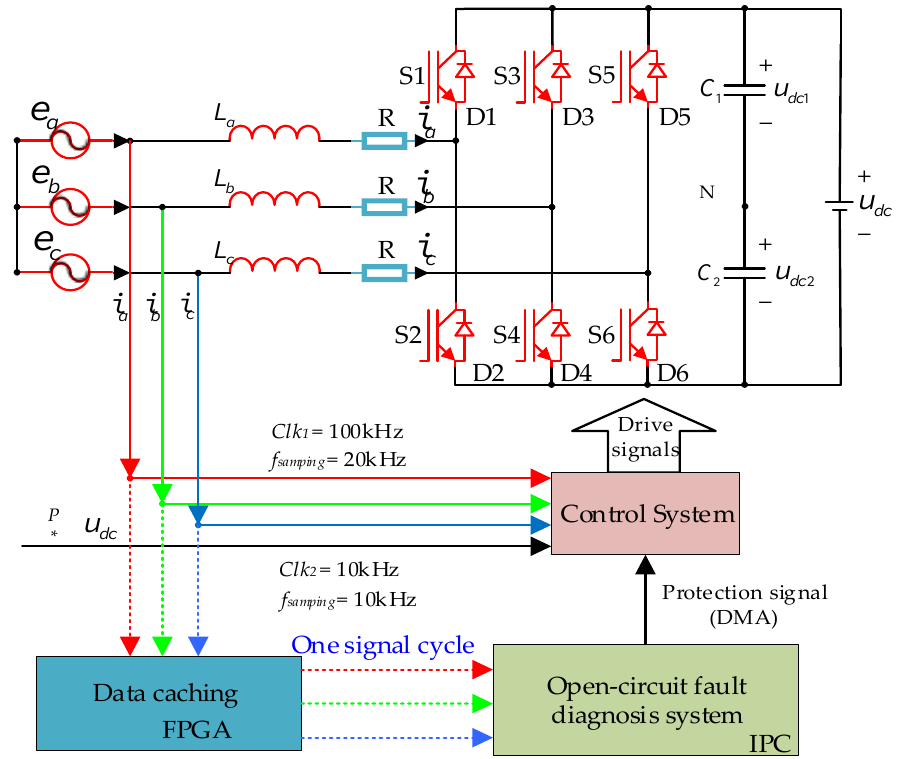
Figure 1. Fault diagnosis system of three-phase PWM converter.